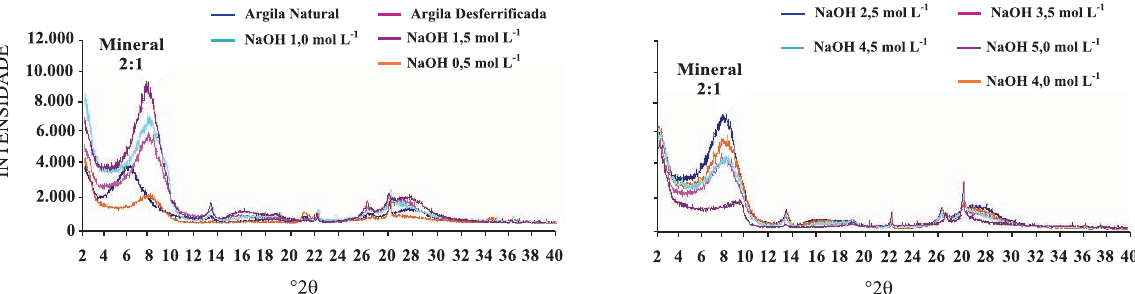
Figura 2. Difratogramas de raios X de amostras orientadas de argila natural e desferrificada, antes e após os tratamentos com diferentes concentrações de NaOH, do horizonte C4 do perfil do Setor de Ciências Agrárias (SCA) da UFPR. A distância basal d(001) do mineral 2:1 variou de 1,58 nm (natural) a 1,0 nm (NaOH 5 mol L -1